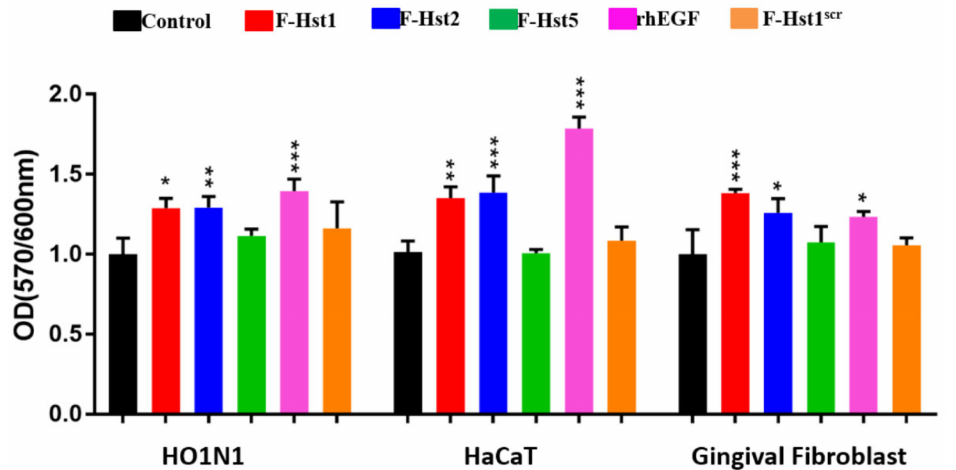
Figure 10. Graph depicting the e ff ects of Hst1, Hst2, Hst5, recombinant human epithelial growth factor (rhEGF) (as a positive control) and F-Hst1 scr (as a negative control) on the cellular metabolic activity of HO1N1 human epithelial cells, HaCaT human keratinocytes and primary gingival fibroblasts measured using PrestoBlue assay. The results showed that Hst1 and Hst2 but not Hst5 or F-Hst1 scr significantly enhanced cellular metabolic activity of HO1N1 epithelial cells. The positive control rhEGF could significantly enhance the metabolic activity of all the three types of cells. Data were presented as mean ± SD. *: p < 0.05; **: p < 0.01; ***: p <